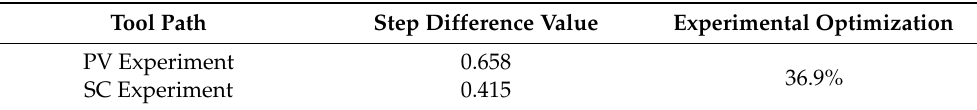
Table 3. Comparison of experiment